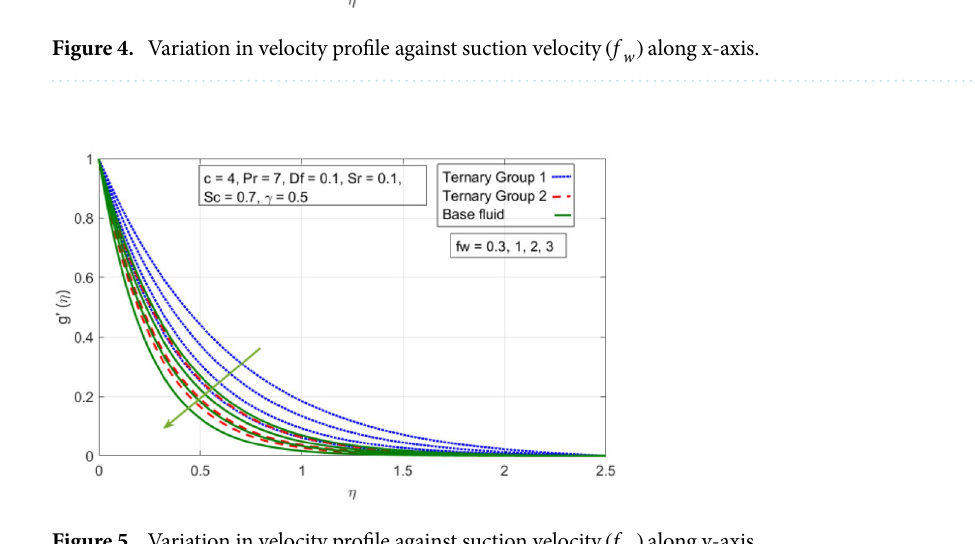
Figure 5. Variation in velocity profile against suction velocity ( f w ) along